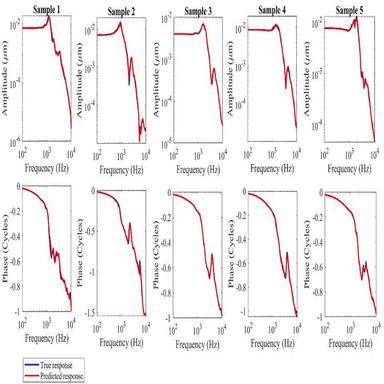
Results of predictions of created ML models for the amplitude and phase of the stapes footplate. Results of five random samples from the testing dataset are presented here. The ML models can fairly represent the amplitude and phase of the stapes footplate at almost all frequencies. The difference between the predicted and true values of the displacement amplitude of the stapes footplate in these 5 samples is less than 2 dB at more than 91% of frequencies. Also, for all samples shown in this figure, the cosi